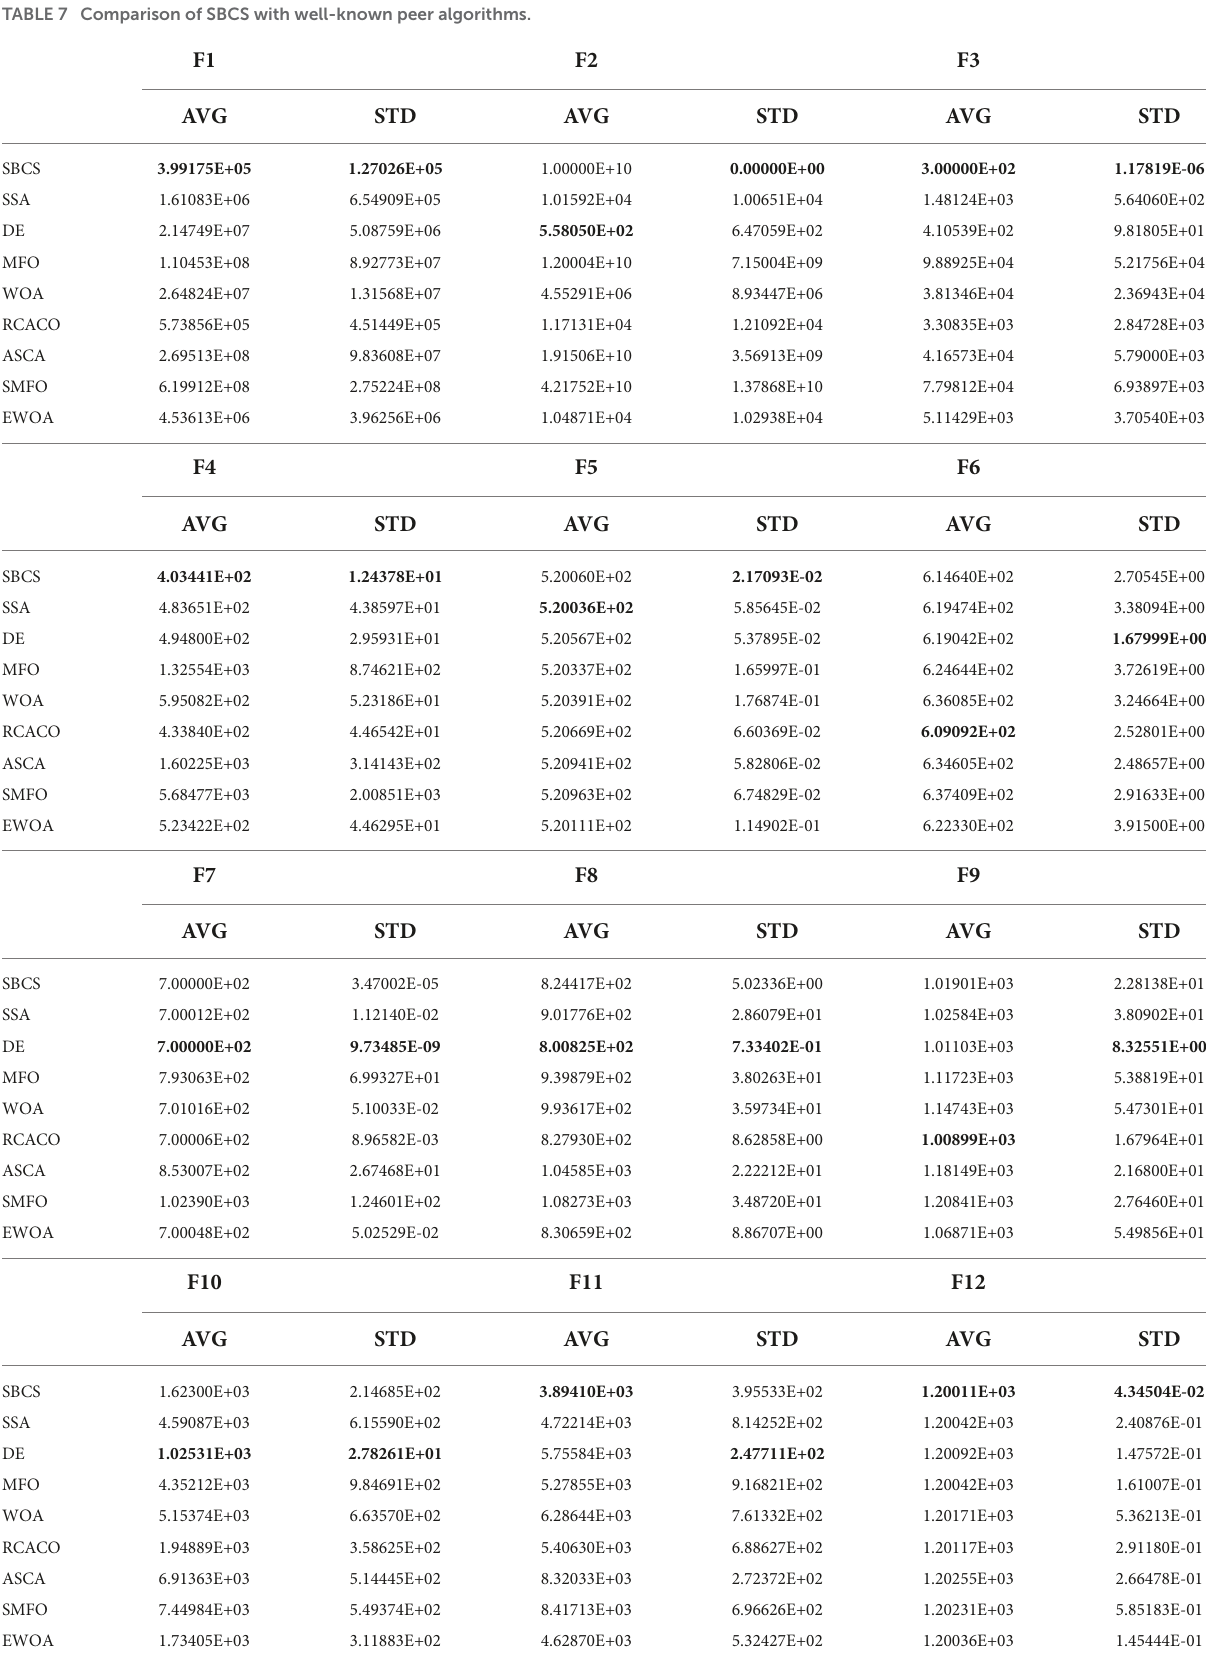
TABLE 7 Comparison of SBCS with well-known peer